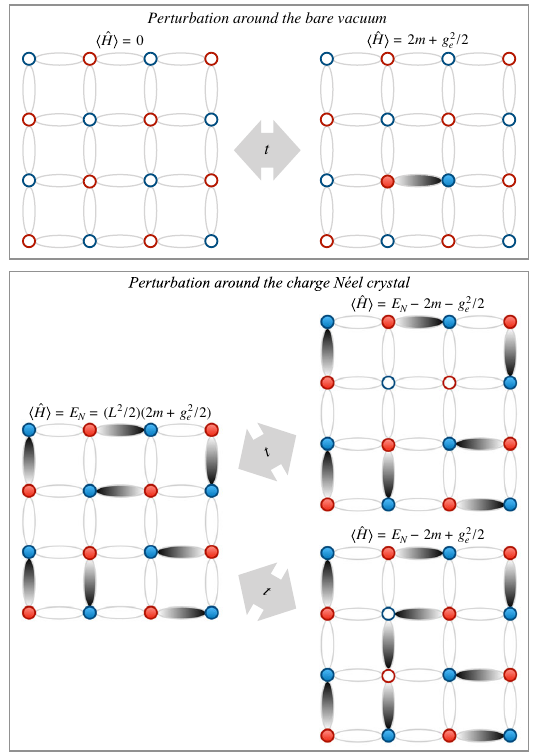
FIG. 16. Example of excited states coupled to the vacuum (top) or to the fully dimerized state (bottom) at the lowest order in perturbation theory in the tunneling coupling t , as described in Appendix